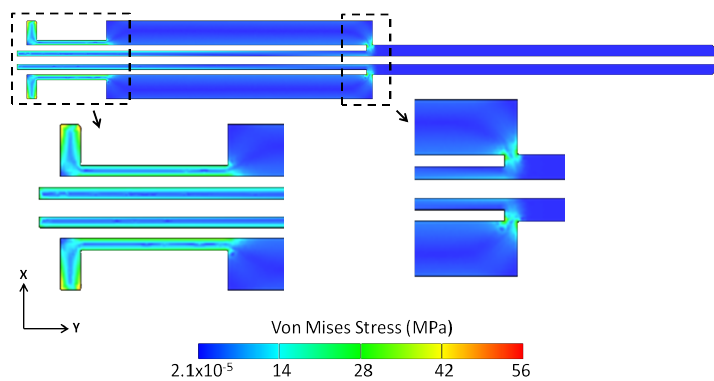
Figure 15. Von Mises stresses developed within the microgripper structure for Design Variant 1 at 3 V with inset images showing detailed views of the stresses where the arms join the anchor pads, within the flexure component and at the connectors joining the hot and cold arms.